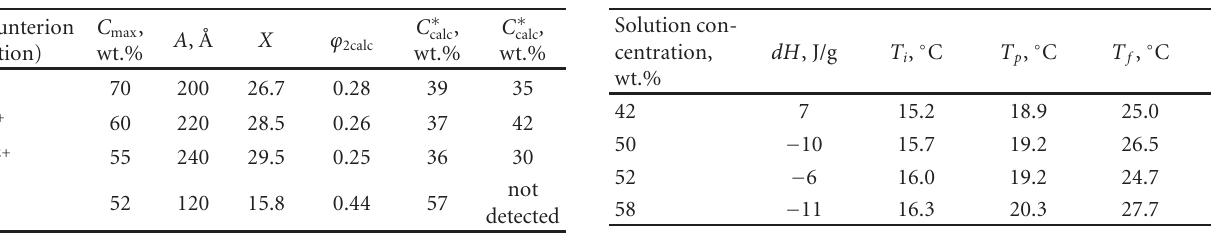
Table 4: Calculated and experimental values of critical LC transi- tion concentration for di ff erent CAS salts.